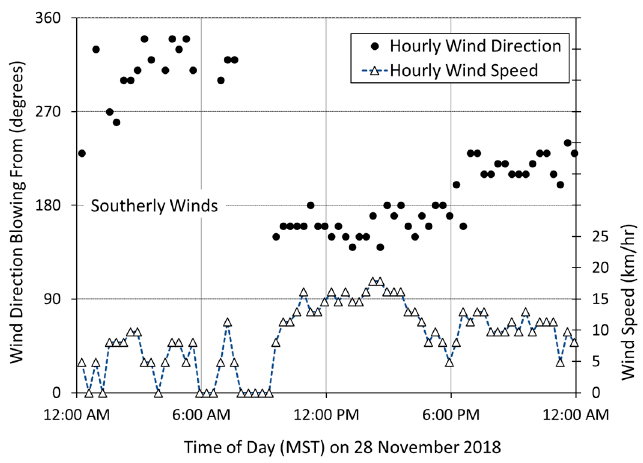
Figure 7. Local wind speed and direction (20 min) plot in Socorro, NM, on 28 November 2018. Table 2. IMPROVE monitoring site reconstructed 24 h average light extinction coefficient (Mm − 1 ) data for 28 November 2018. NA = Data Not